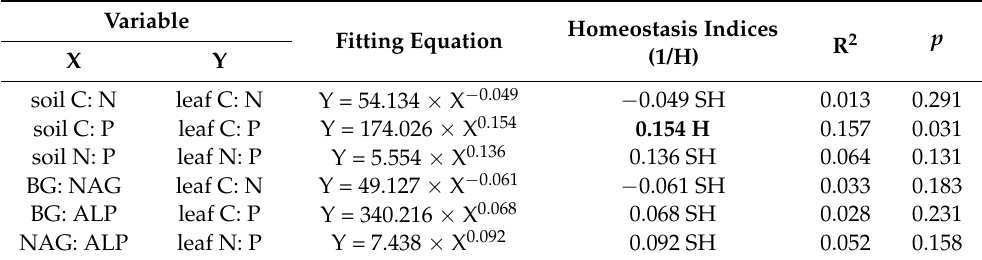
Table 2. Stoichiometric homeostatic relationships between plant leaf and corresponding soil and enzyme